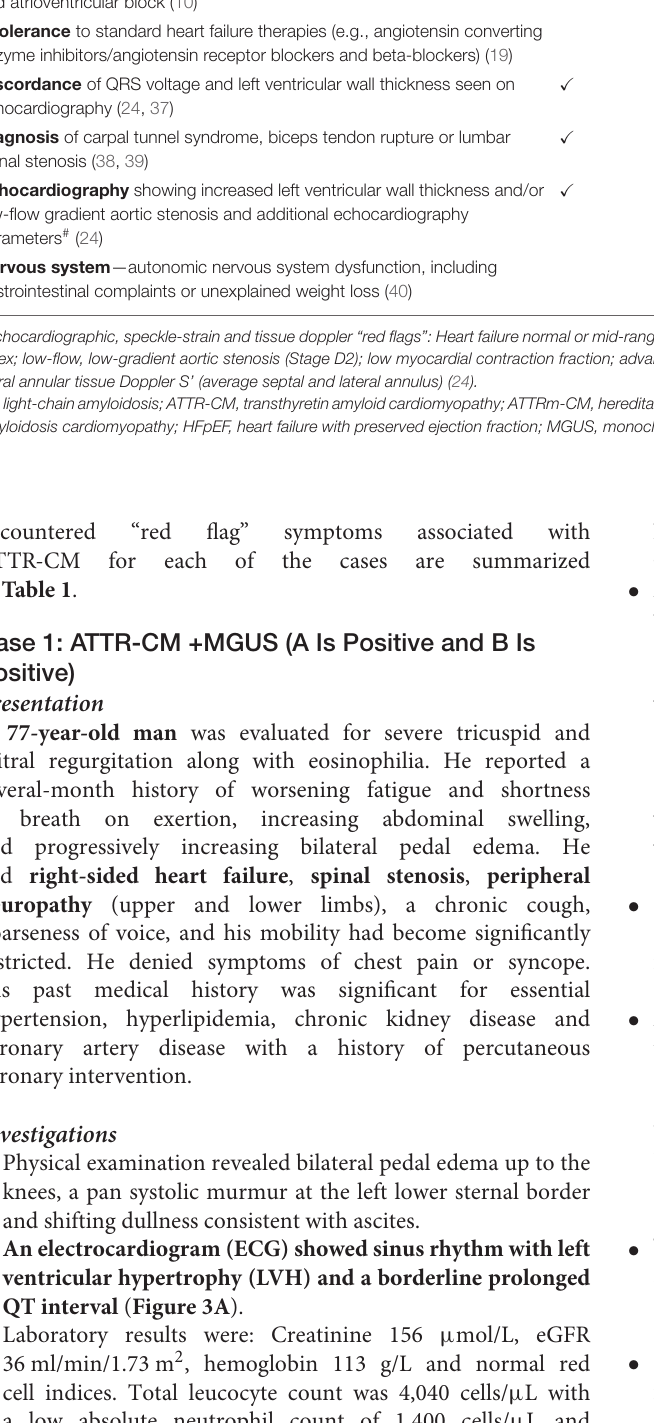
Case 2 Case 3 Case 4 ATTR-CM + MGUS AL amyloidosis ATTRwt-CM